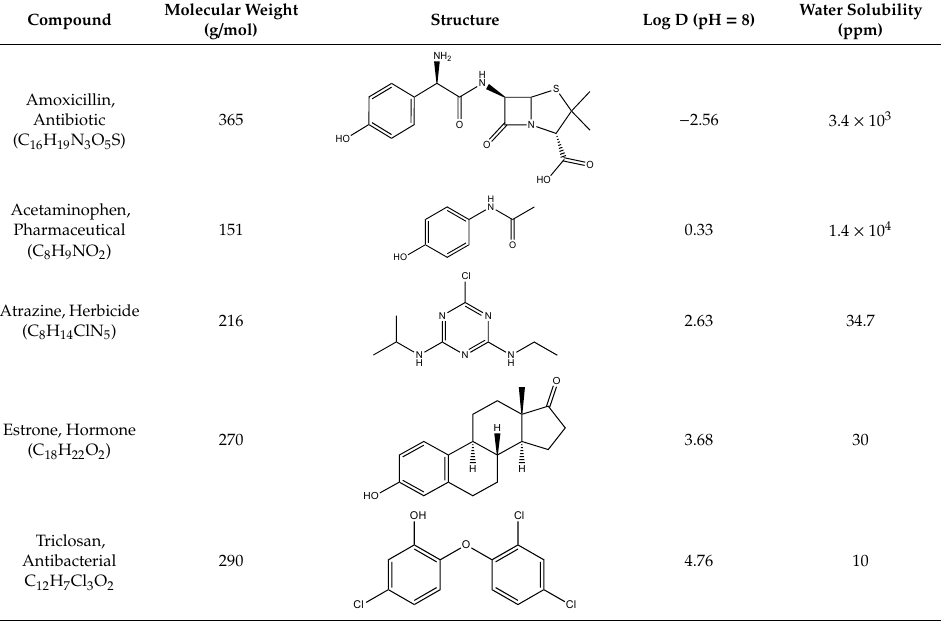
Table 1. The structure and physicochemical properties of the micropollutants.